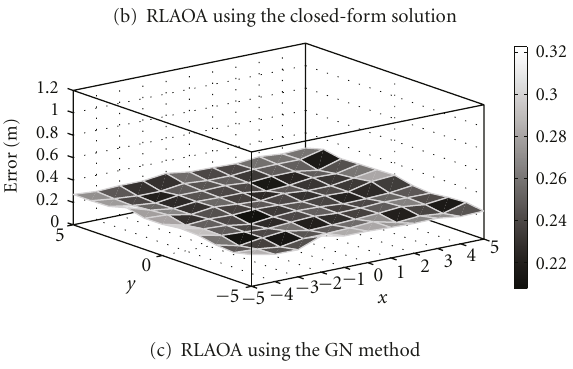
Figure 5: Range estimation